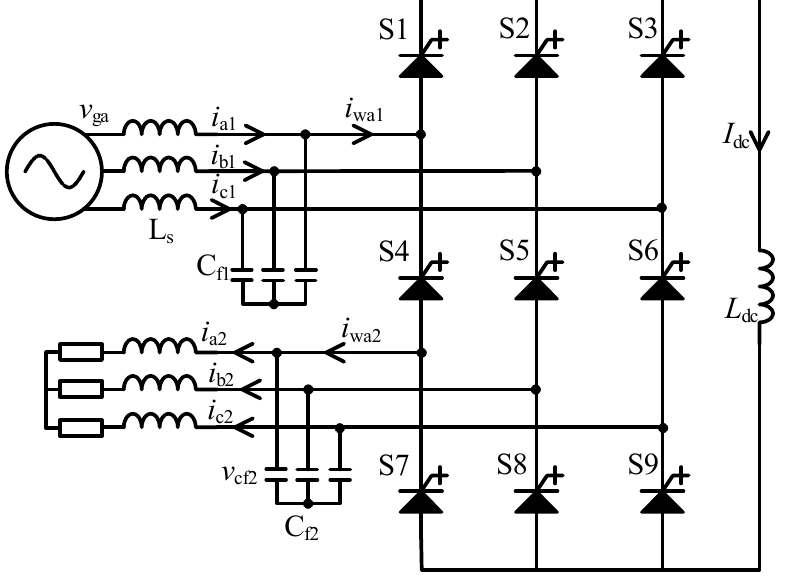
Figure 3. Topology of the nine-switch current source converter.